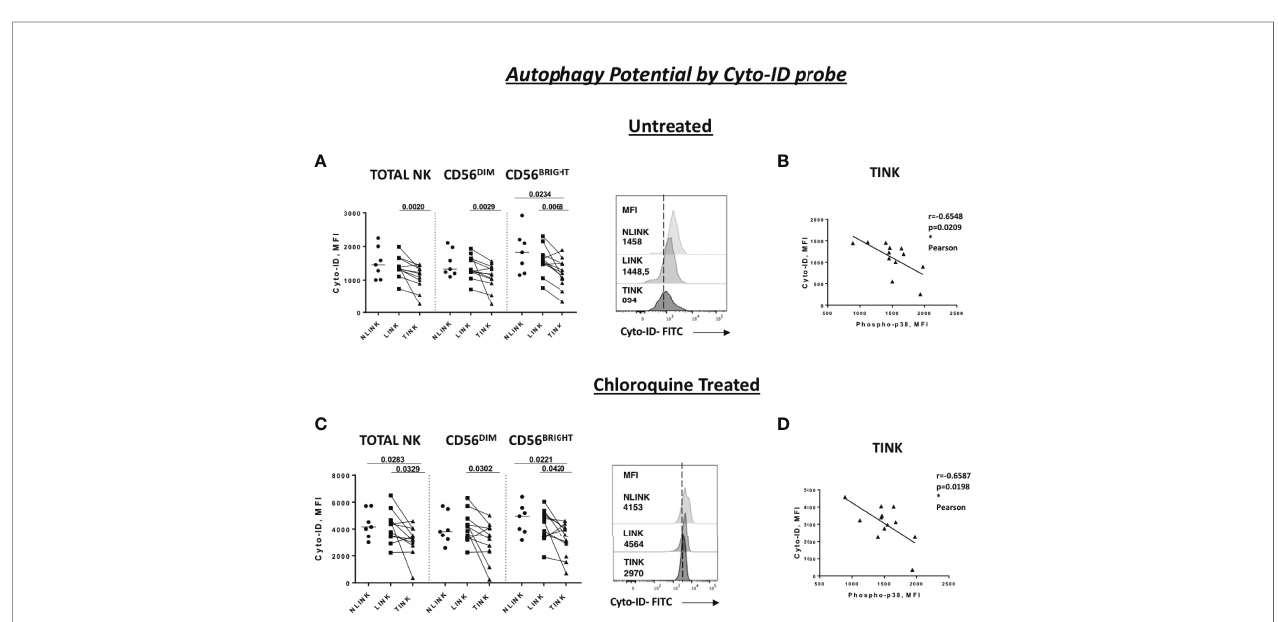
FIGURE 4 | Autophagy capacity in tumor-in fi ltrating NK cells (TINK), non-tumorous liver-in fi ltrating NK cells (LINK), and normal liver-in fi ltrating NK cells (NLINK). Cyto-ID median fl uorescence intensity (MFI) values in TINK ( n = 12), LINK ( n = 12), and NLINK ( n = 7) from untreated (A) and chloroquine-treated (C) samples (total, CD56 DIM , and CD56 BRIGHT NK cells). Examples are shown on the right of each panel. Statistical analysis was performed by Wilcoxon matched pairs test (LINK vs TINK) and Mann – Whitney test (NLINK vs TINK and NLINK vs LINK). Horizontal lines represent median values. Correlation between the Cyto-ID MFI values of untreated (B) and chloroquine-treated (D) and phospho-p38 protein in total NK cells from TINK samples. Statistics by Pearson correlation. *p <